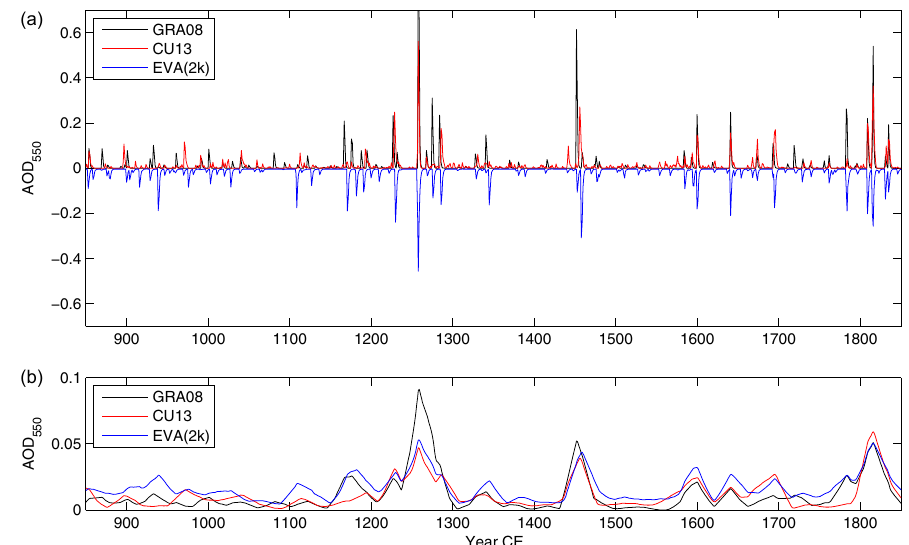
Figure 2. Reconstructions of volcanic forcing, 850–1850CE, shown as global-mean, mid-visible (550nm) aerosol optical depth (AOD) as (a) annual means and (b) a smoothed time series after application of a 21-year wide triangular filter (for visualisation). Reconstructions include the Gao et al. (2008) (GRA08), Crowley and Unterman 2013 (CU13), and PMIP4 recommended forcing, EVA(2k). Note that the AOD in 1258CE for the GRA08 reconstruction extends beyond the axis of the plot, with a value of approximately 1.05. AOD for the EVA(2k) reconstruction is shown on the inverted axis in panel (a) for